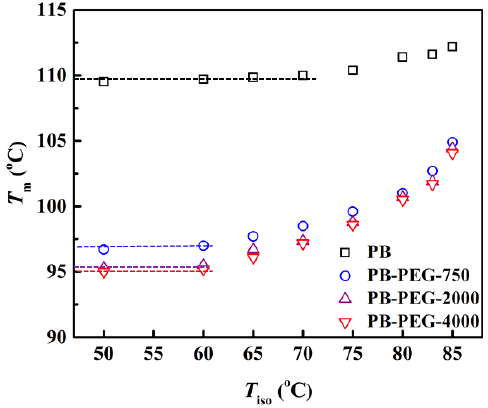
Figure 6. The melting temperatures of the PB and PEG-grafted polybutene-1 crystallites prepared by isothermal crystallization at different temperatures.